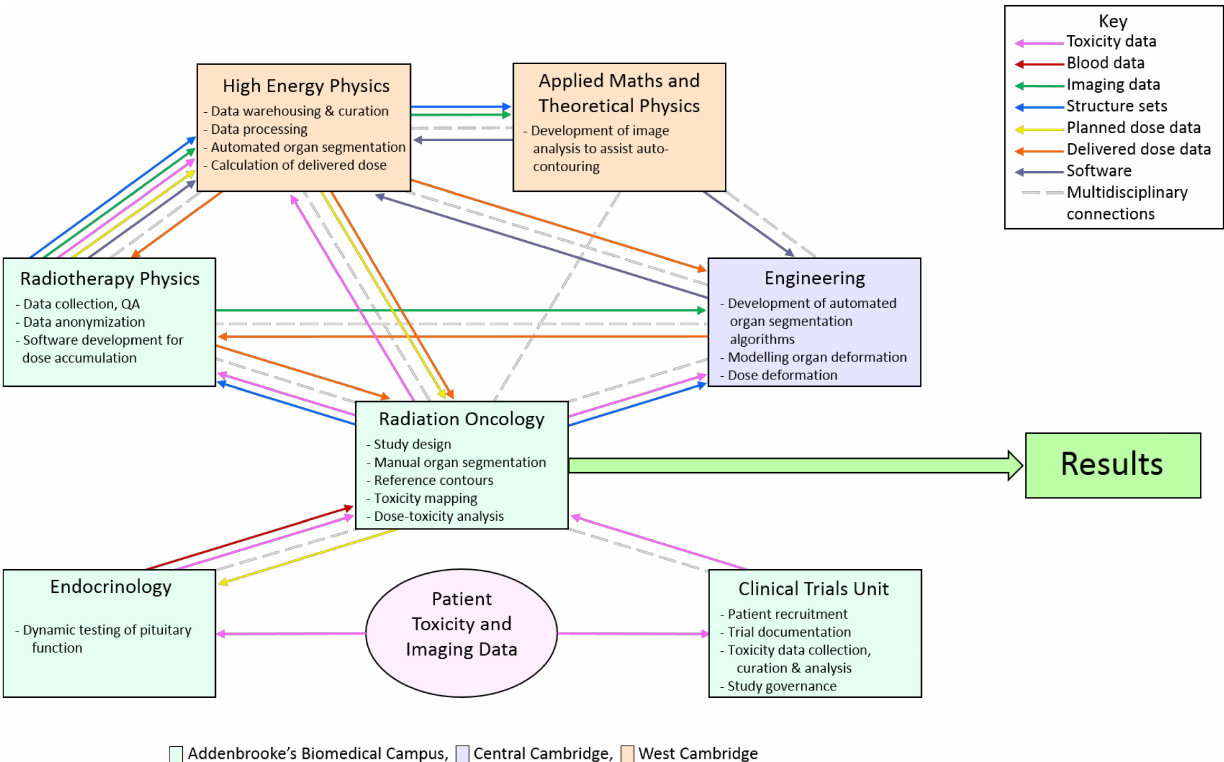
Fig. 5. Administrative and scientific multidisciplinary connections, together with data flows used in the Programme. Background colours indicate on which campus each group is